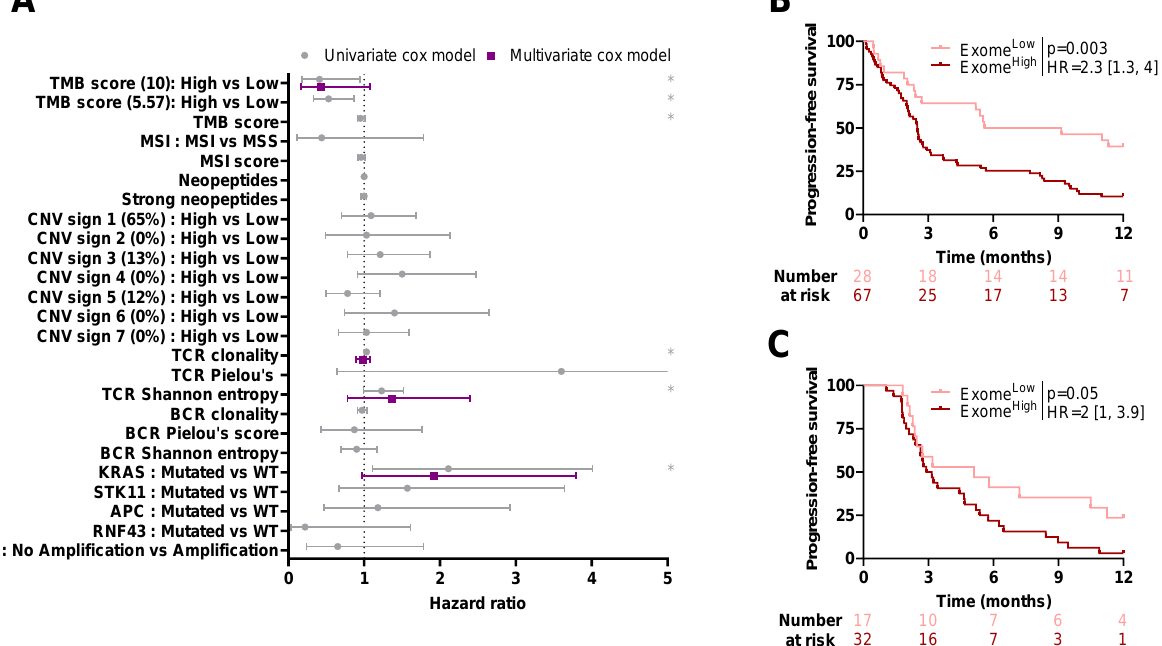
Figure 4: Association between progression-free survival and exome-derived variables. Figure 4. Association between progression-free survival and exome-derived variables: ( A ) Forest plots (A) Forest plots representing hazard ratios and confidence intervals for univariate (grey) and multivariate (purple) Cox models for progression-free survival estimated using exome-derived variables in the training cohort. *: Log-rank test p-value≤0.1. representing hazard ratios and confidence intervals for univariate (gray) and multivariate (purple) (B-C) Kaplan-Meier curves with patients stratified according to the exome model dichotomized by optimal cut-off (High vs Low) for progression-free survival for the training cohort (B) and validation cohort (C). TMB: Tumor Mutational Burden, MSI: Microsatellite Instability, MSS: Microsatellite Stable, CNV: Copy Number Variant, TCR: T-Cell Receptor, BCR: B-cell Receptor, WT: Wild-Type